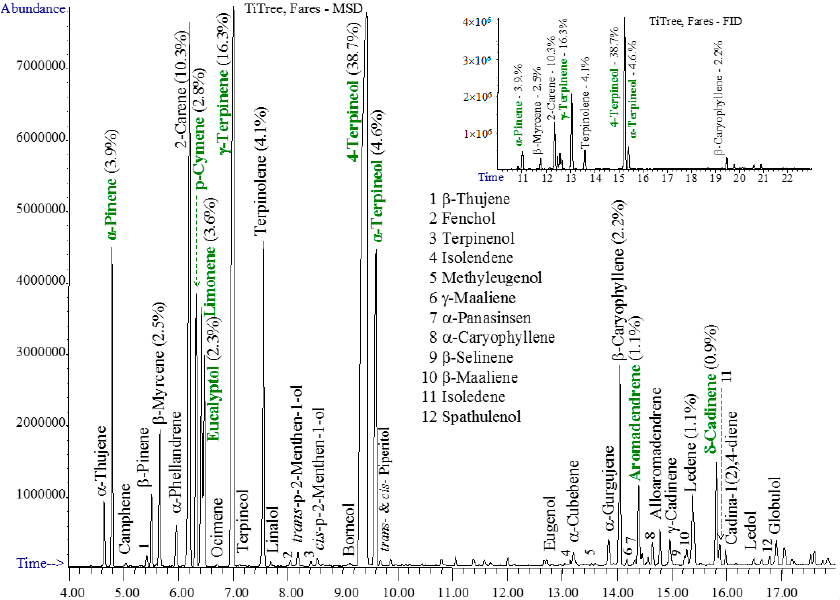
Figure 4. The GC-MSD and GC-FID (insert) chromatograms of tea tree oil.